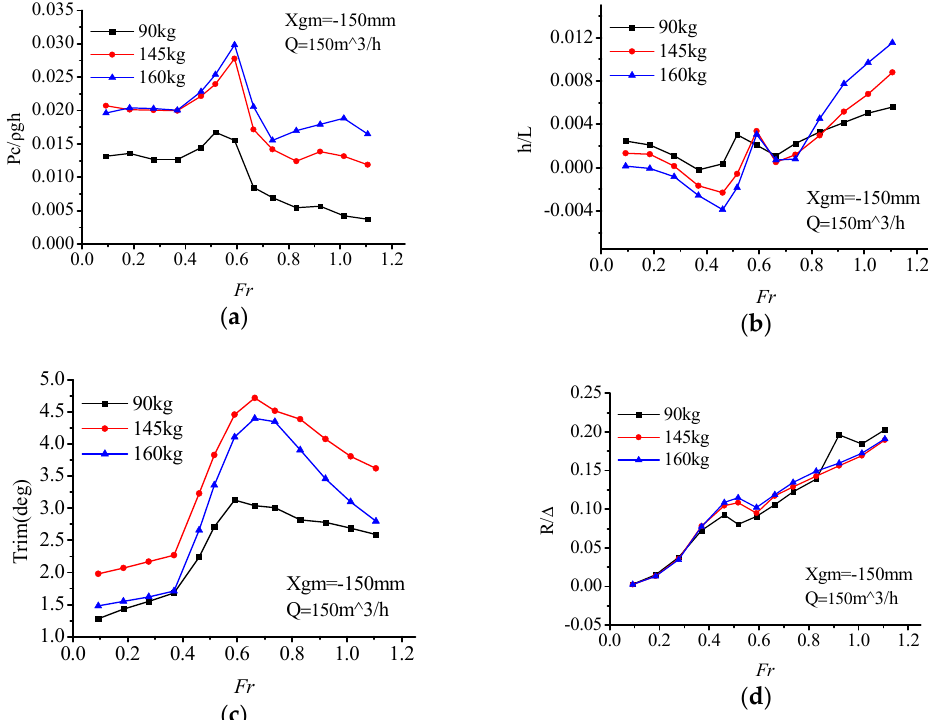
of total resistance.